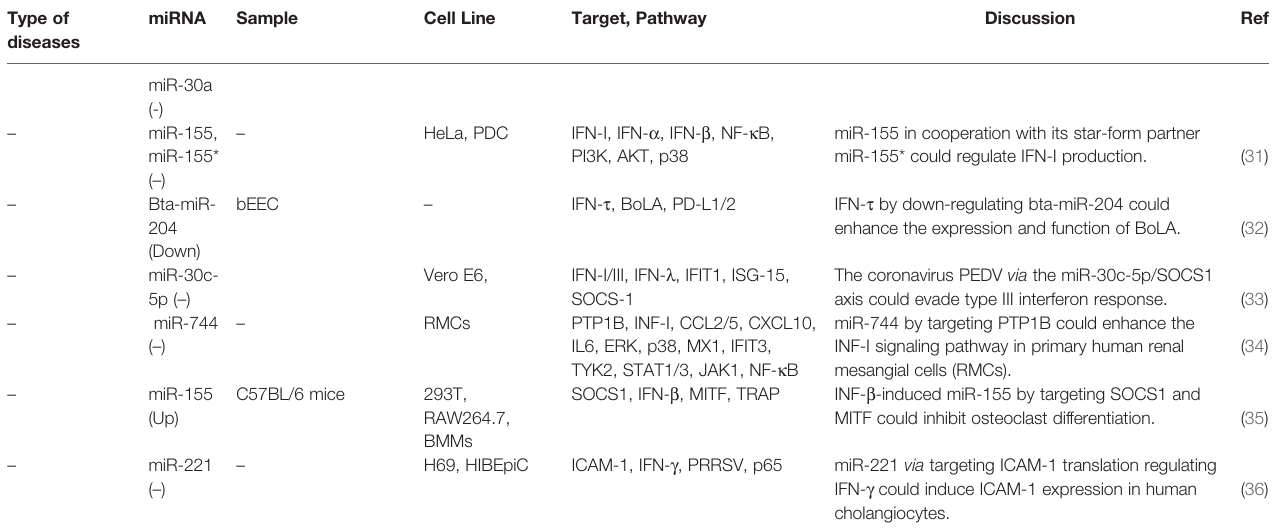
gene expression through modulation of histone or DNA